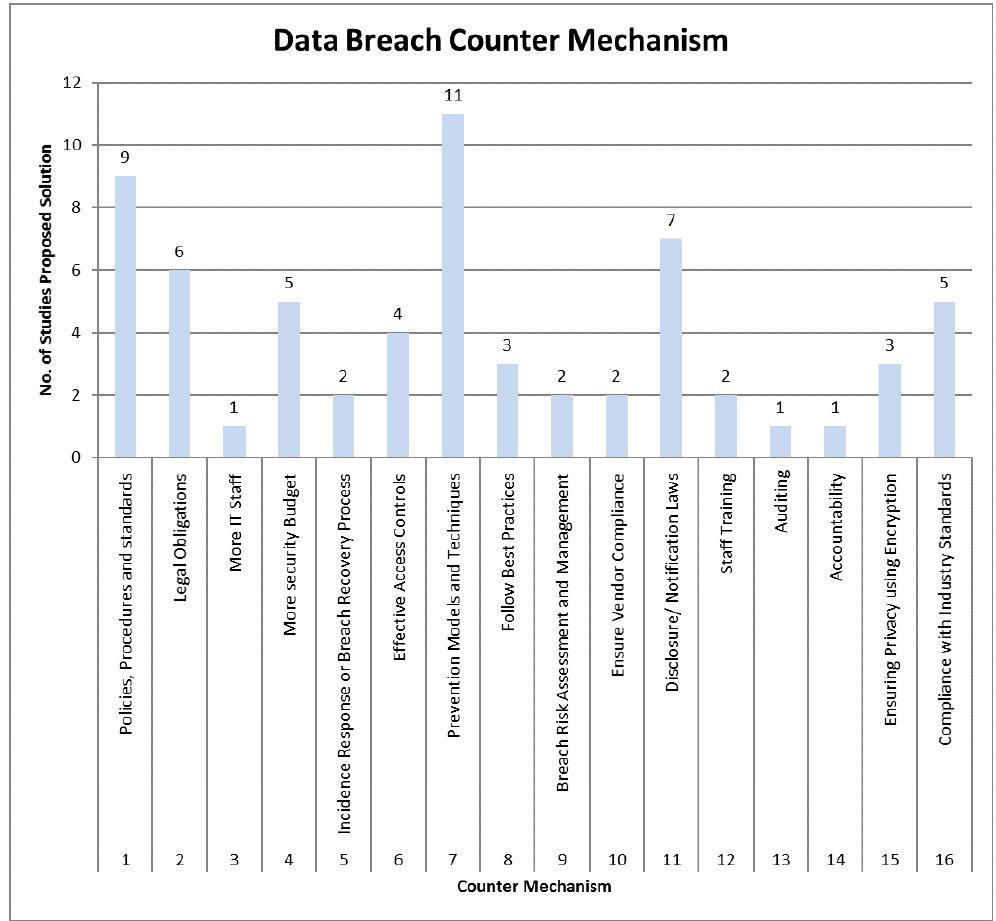
Figure 7. Graphical view of all counter measures to data